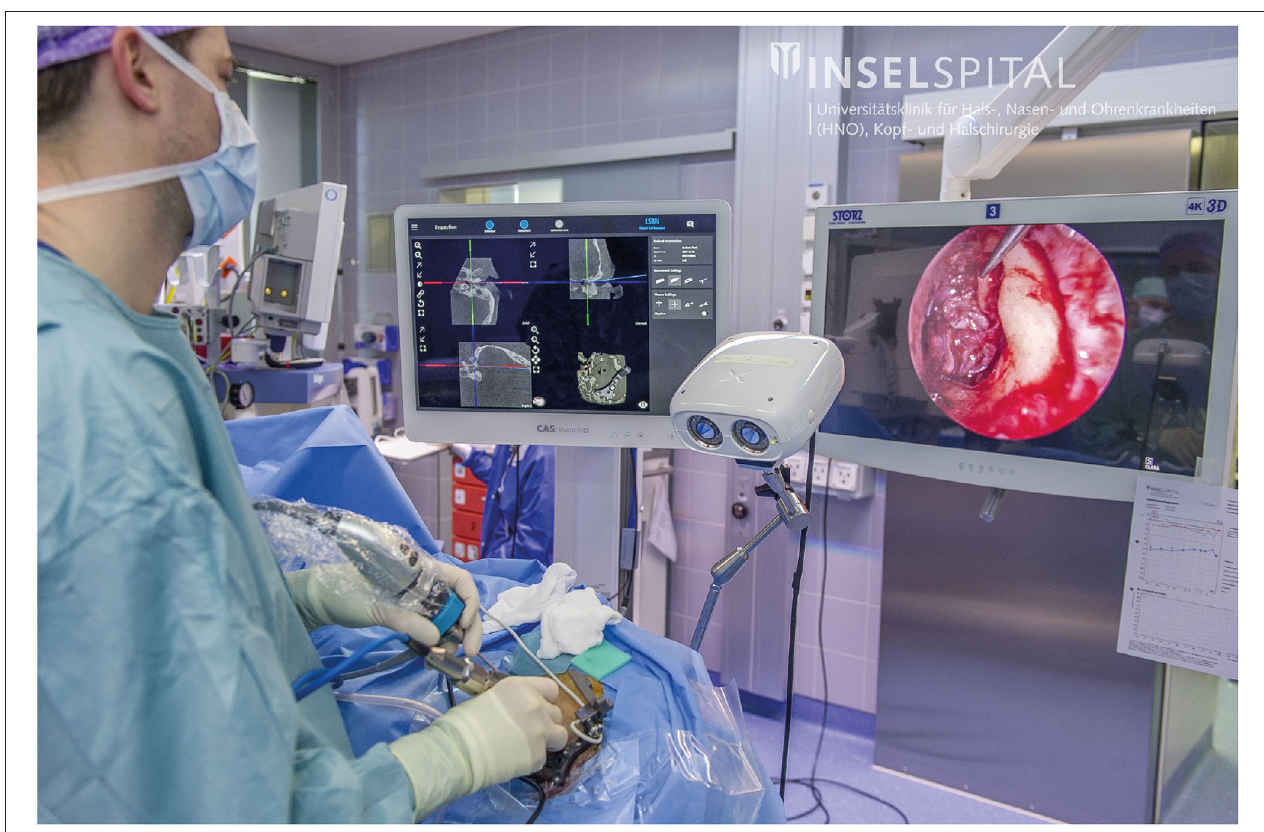
FIGURE 9 | Freehand stereotactic image-guidance during an endoscopic cholesteatoma